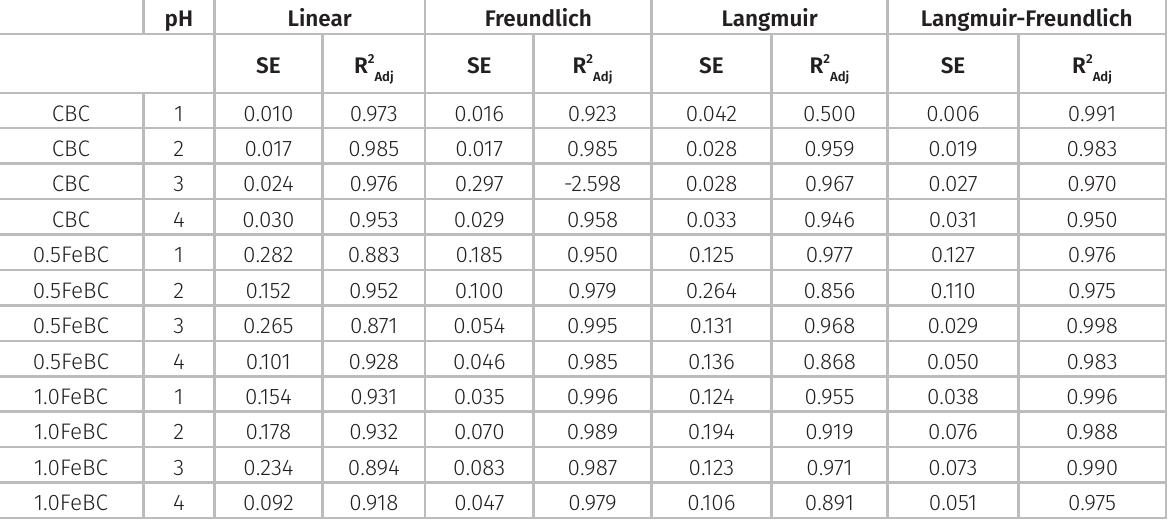
Table IV. Standard error (SE) and determination coefficients (R 2 ) of isotherms data in linear, Freundlich, Langmuir and Langmuir-Freundlich models. pH